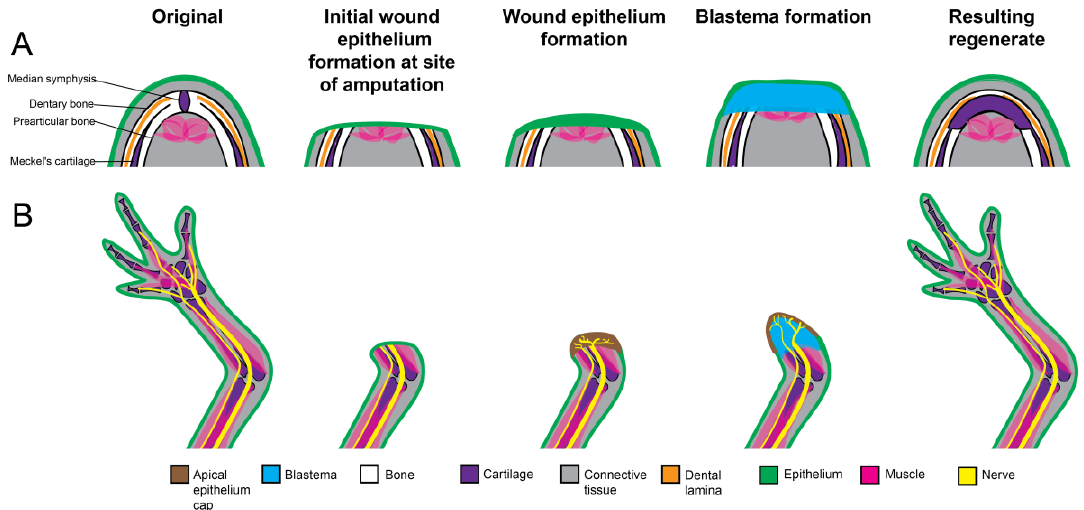
Figure 2. Differences and similarities in blastema and structure formation during adult Urodele jaw and limb regeneration. ( A ) The stages of jaw regeneration. The intact amphibian jaw consists of Meckel’s cartilage, dentary and prearticular bone, and the median symphysis connecting both sides of the jaw. The hyoid and brachial skeletons have been removed for simplicity. Upon amputation, a wound epithelium forms over the remaining jaw stump tissue. Independent of nerve singling, blastema cells accumulate at the severed edge of the jaw, derived from a variety of mature stump tissues, and will proliferate, repattern, and differentiate into a structure similar to the original structure, but with notable differences. The medium symphysis is lost and the majority of regenerated skeleton is cartilaginous (connect with Meckel’s cartilage), with only the dentary bone being restored. ( B ) The stages of limb regeneration. Limb regeneration also requires blastema formation, however its induction is slightly different from that of jaw regeneration. After amputation, a wound epithelium (WE) forms over the severed edge of the limb stump. The WE becomes innervated by the regenerating neurons, and establishes a specialized wound epithelium known as the Apical Epithelial Cap (AEC). The AEC is required for the dedifferentiation of the limb stump cells into blastema cells. The blastema cells, also derived from a variety of mature tissue, proliferate, pattern, and redifferentiate into all of the missing limb structures. The resulting limb regenerate is identical to the original.